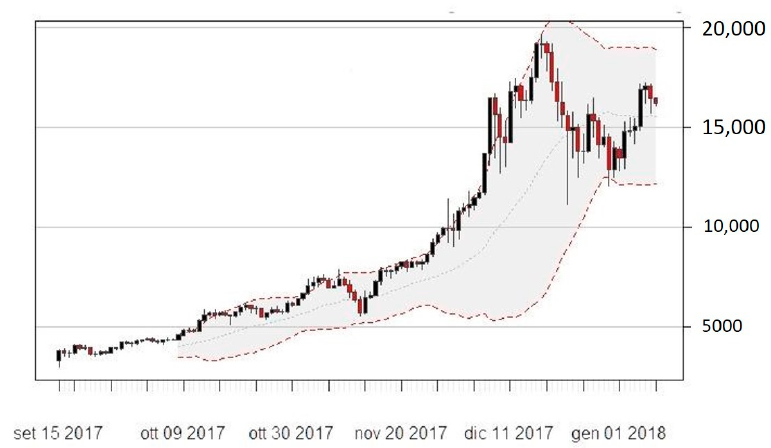
Figure 5. BBs12 ( top panel) and BBs24 ( bottom panel) on Bitcoin daily price series.